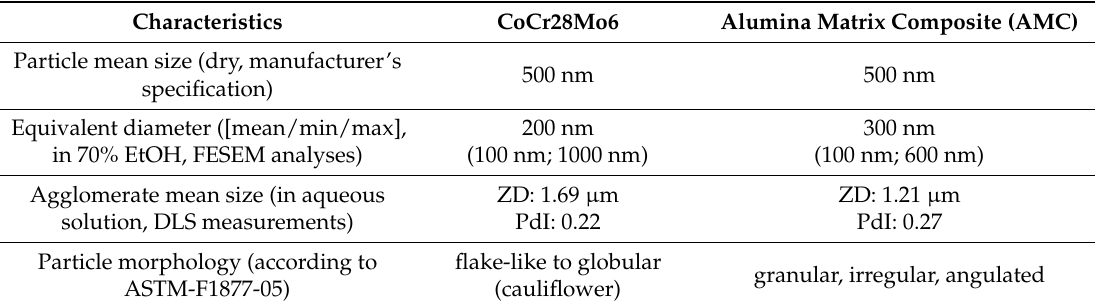
Table 1. Specifications of the used particles [19].